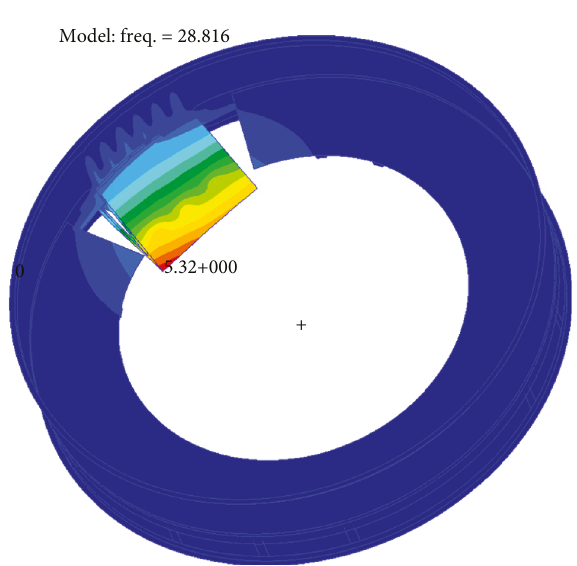
Figure 11: First modal shape of the equipment bay (with mass).